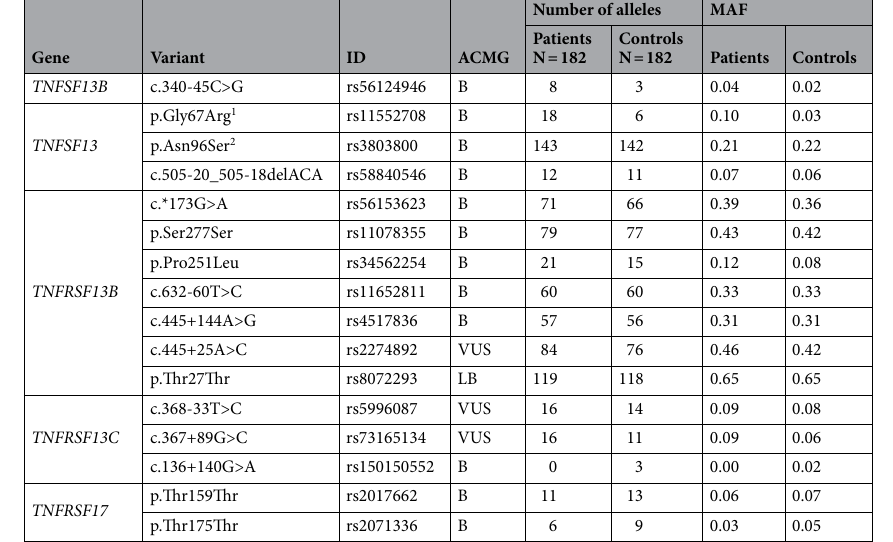
Table 4. Association of the gene common variants with SLE. ACMG American College of Medical Genetics and Genomics. 1 All p-values > 0.05 except TNFSF13 p.Gly67Arg p value = 0.014 FDRadj.pval > 0.05. 2 MAF (Minor Allele Frequency) correspond to the reference that is the minor allele in EUR.